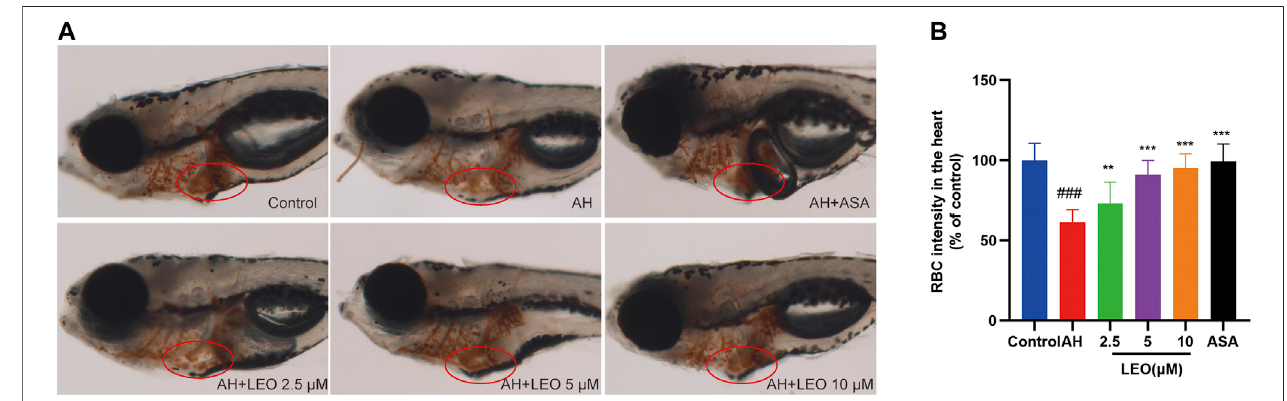
FIGURE3| EffectofLEOonAH-inducedthrombosisinzebra fi shlarvae. (A) Imagesoferythrocytesstainingintheheartofzebra fi sh,redcircleindicatesthestaining oferythrocytesintheheart. (B) TheRBCsintensity(%ofcontrol). Dataarerepresentedasmean ± SD( n (cid:1) 20).# p < 0.05, ## p < 0.01 ,### p < 0.001 vsControlgroup;* p < 0.05 , ** p < 0.01, *** p < 0.001 vs AH